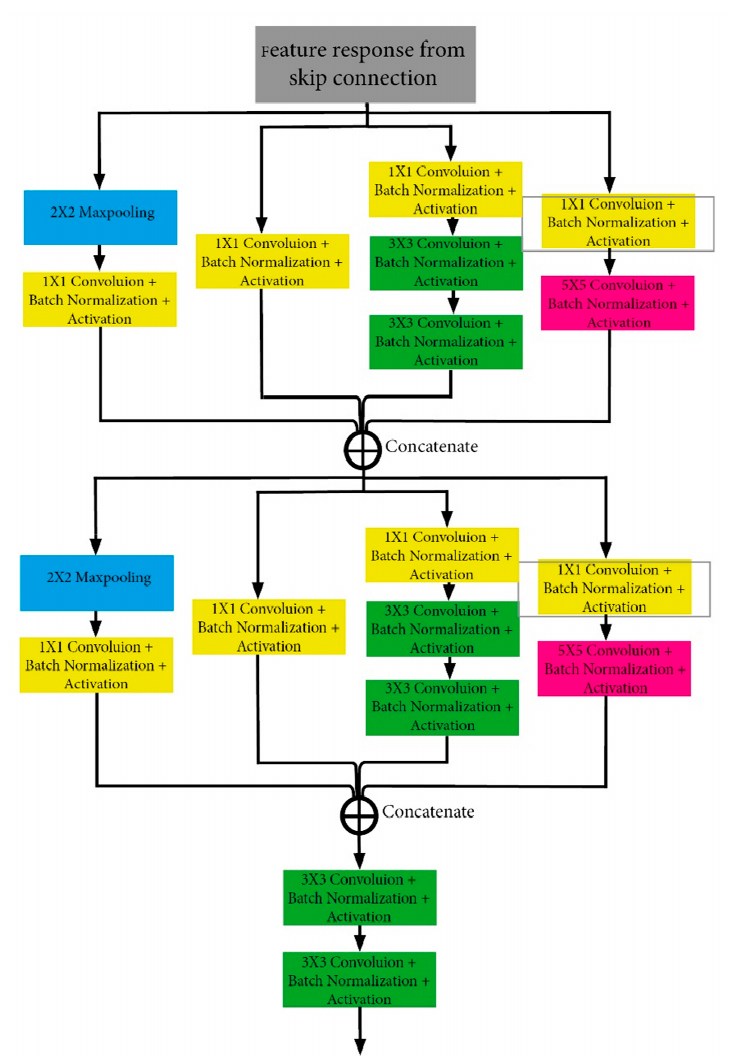
Figure 3. Diagram of inception module part (IMP) .